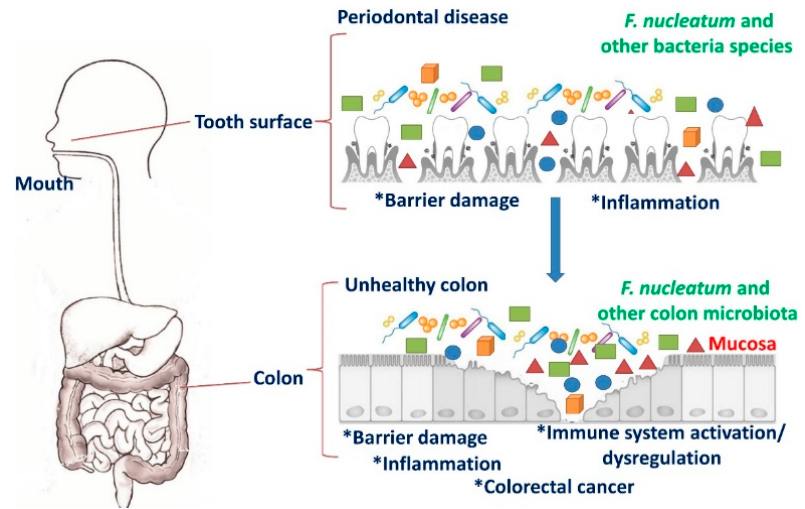
Figure 1. Migration of F. nucleatum from the oral cavity to colon that promote colorectal cancer (CRC).